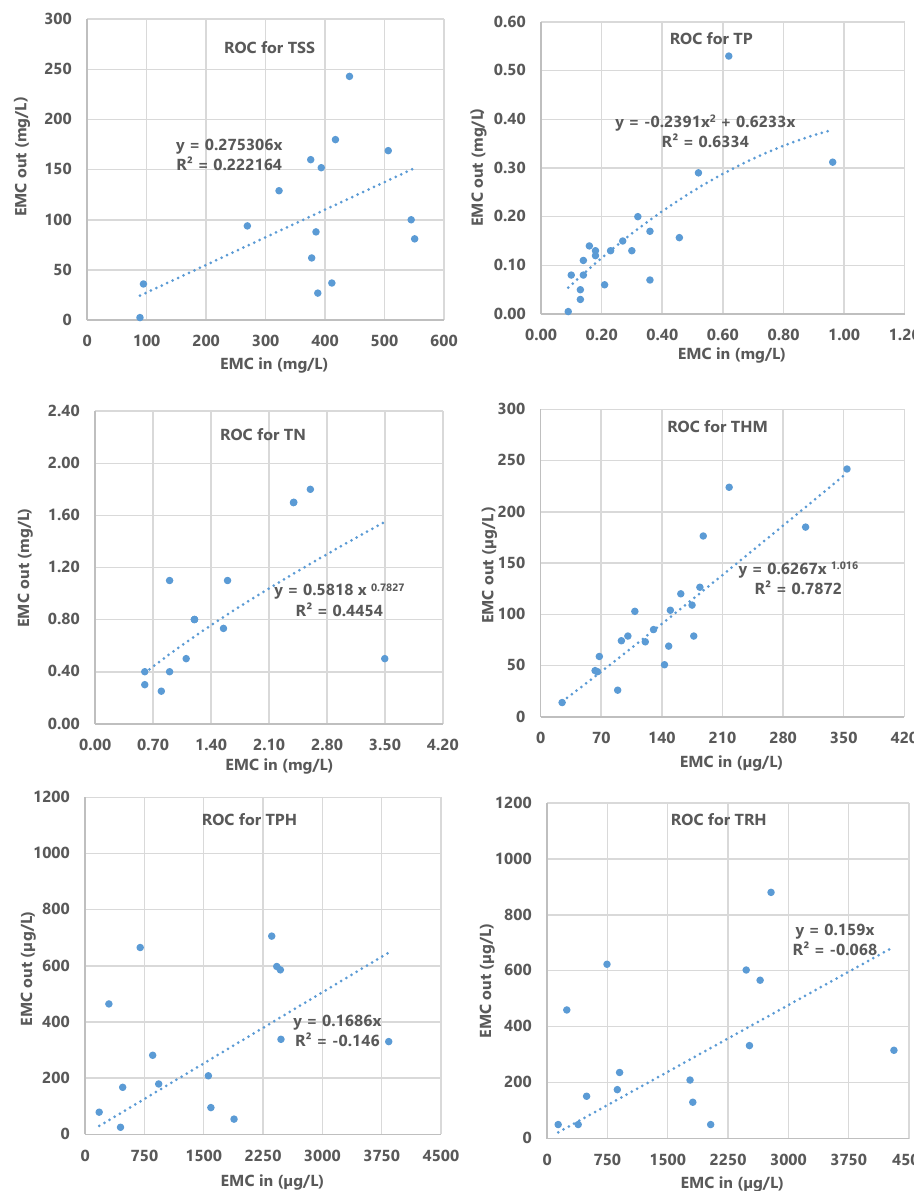
Figure 10. Regression fitting curves for pollutant concentrations (ROC).